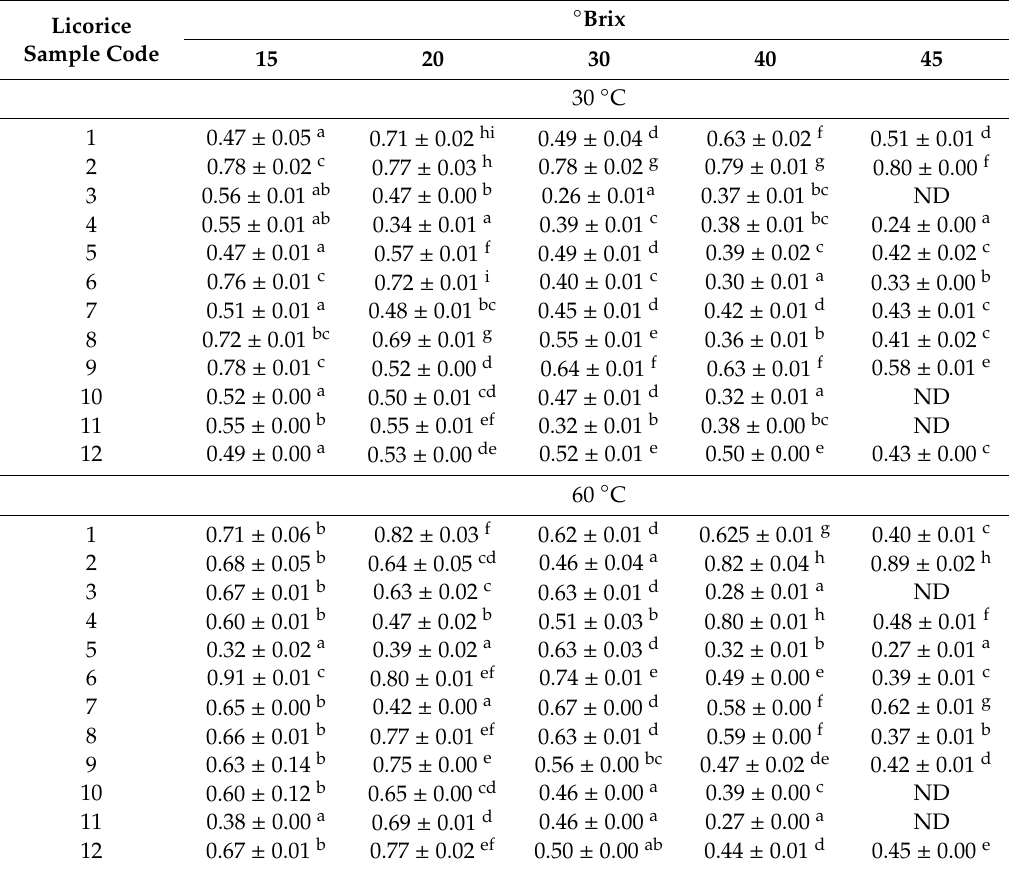
Table 3. Flow behavior indexes, n , of twelve licorice extract samples harvested at various seasons and produced using the same commercial licorice processing line as a function of degrees Brix at 30 and 60 ◦